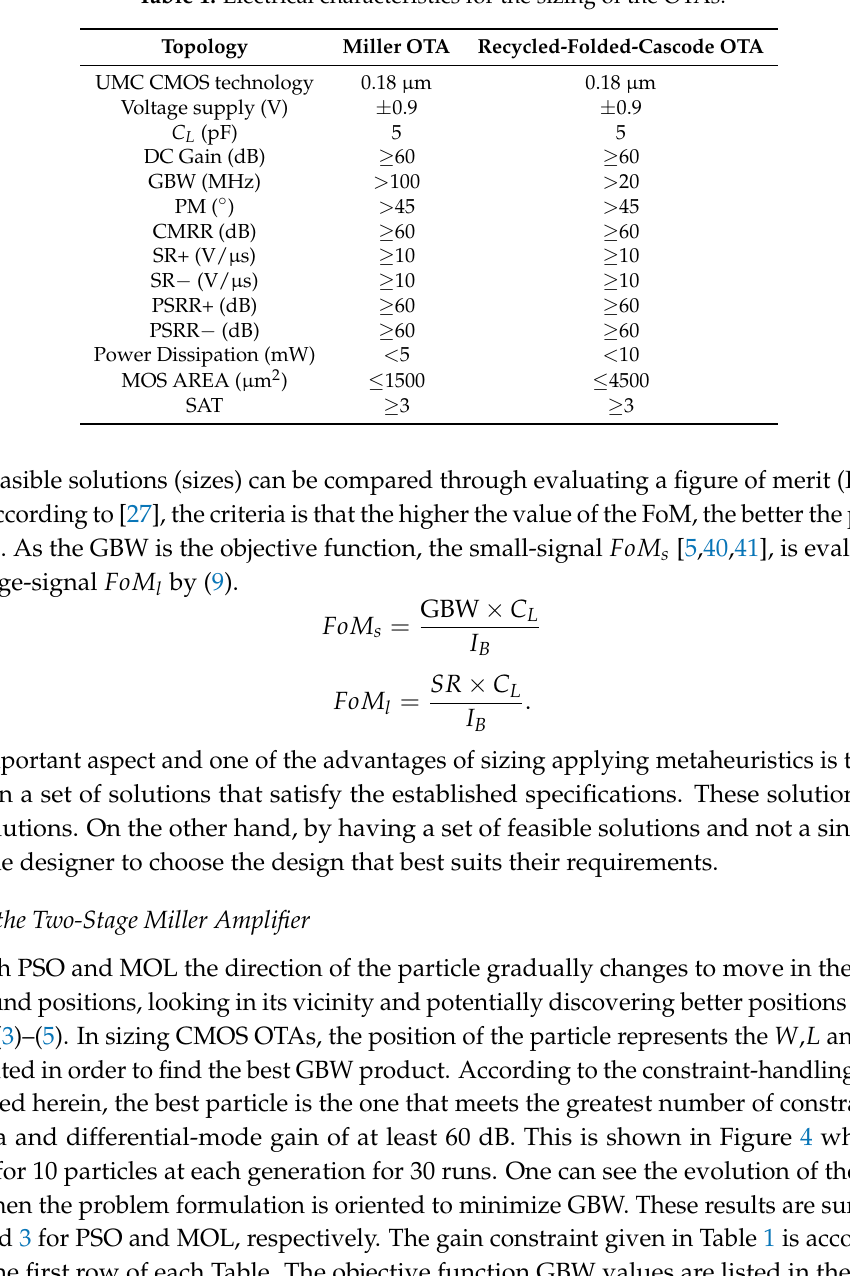
Table 1. Electrical characteristics for the sizing of the